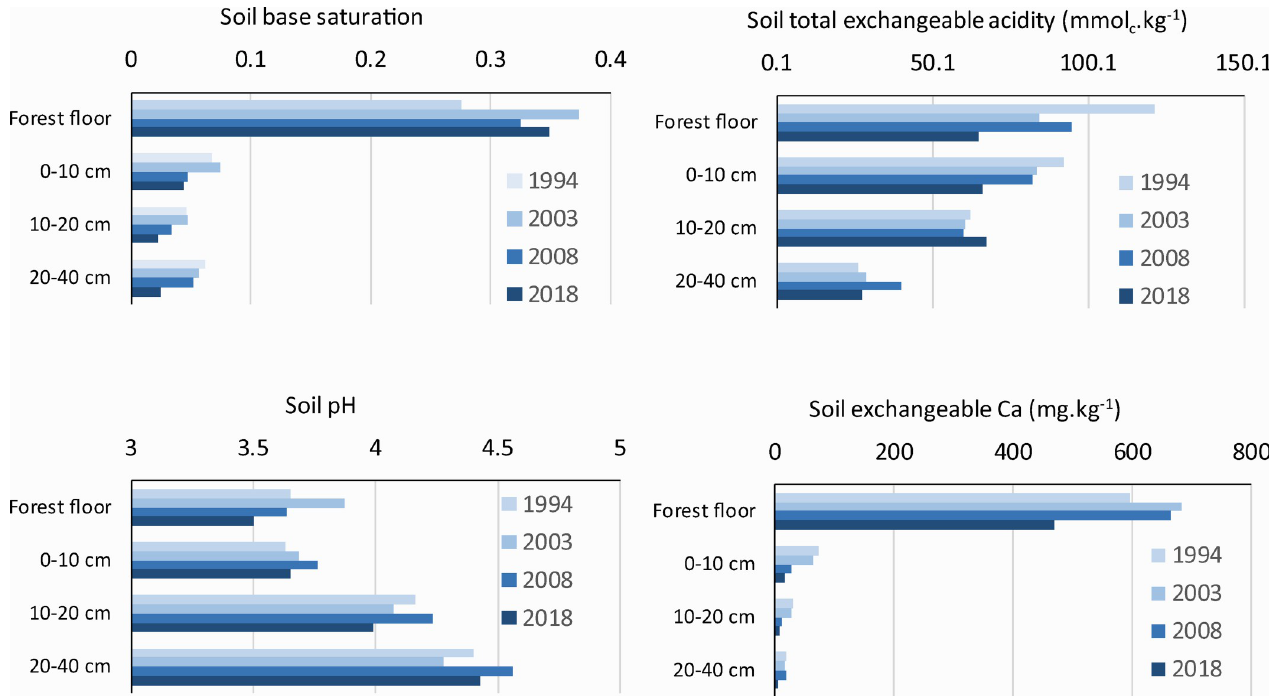
Fig 6. Long-term changes of soil chemistry at the Na č etı´n control research site (1994–2018).